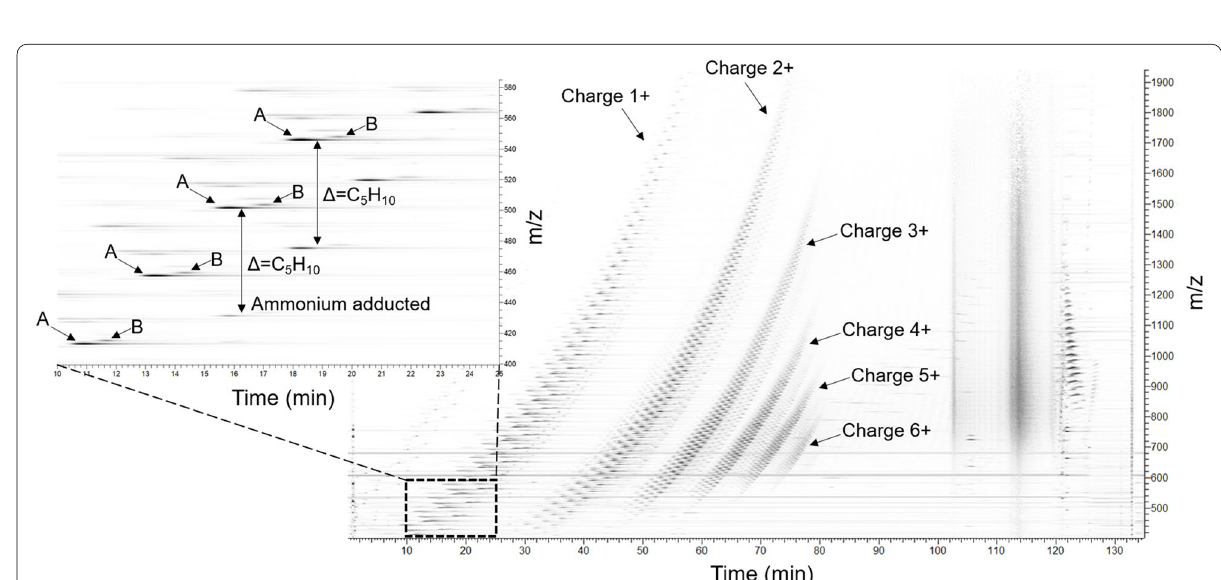
Fig. 8 The mass map overview of P188 and its degradants. The inset is the amplified area marked in the dashed square. Series A is at m/z 414.3 and B is at m/z